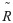
Comparisons of the HPBW when R˜ is varied.